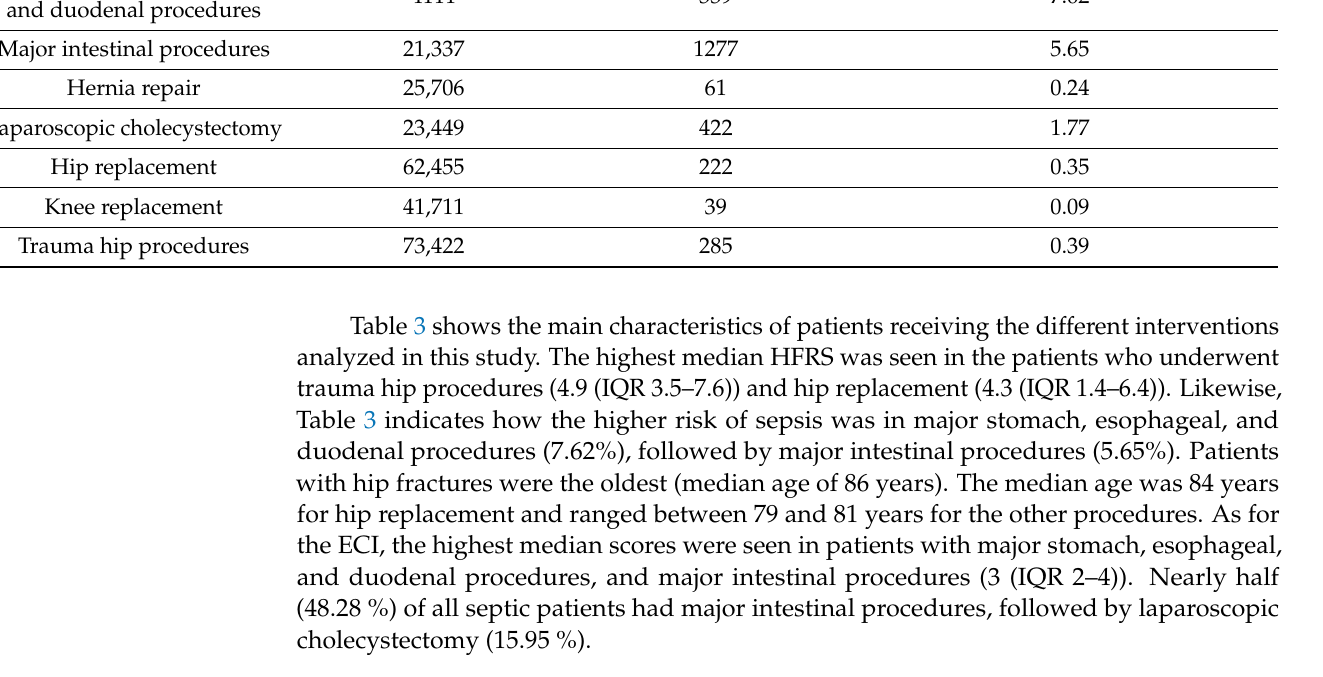
Table 3. Patient characteristics by Diagnosis-Related Groups ( n =